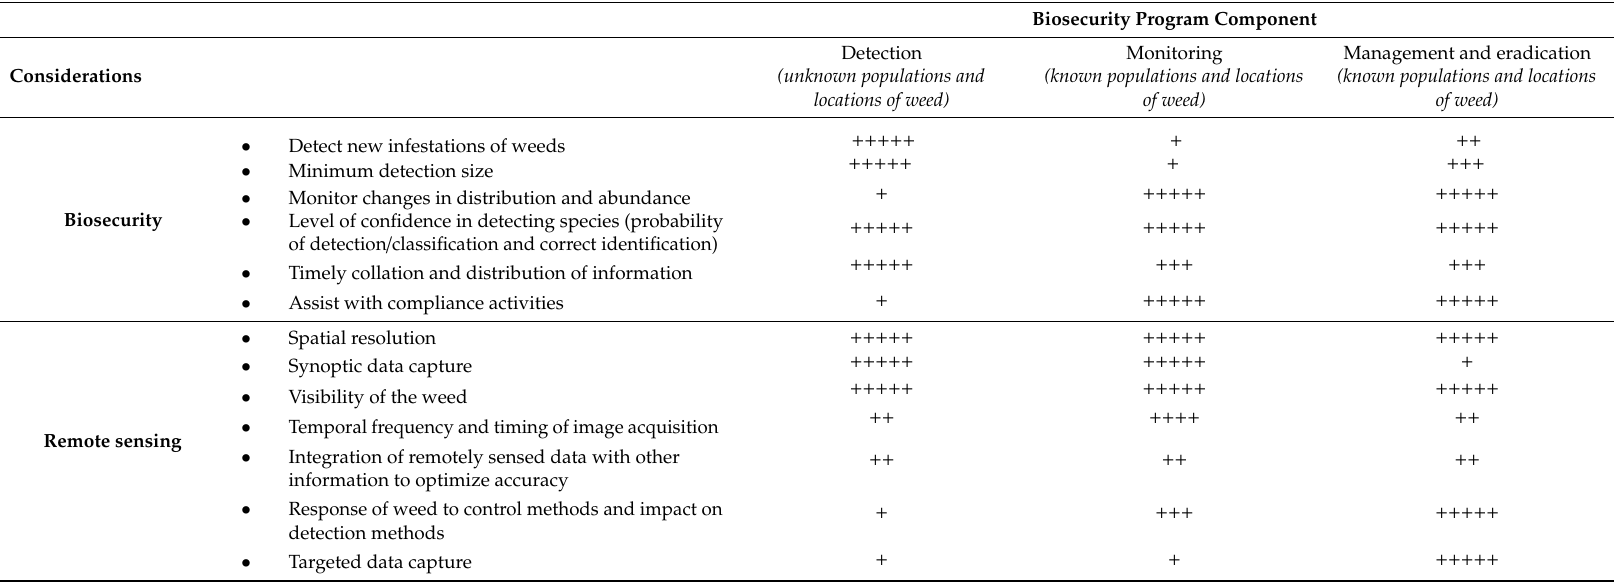
Table 1. Summary of weed biosecurity program components and relative importance of key considerations from biosecurity and remote sensing perspectives ( + = lower relative importance, +++++ = higher relative